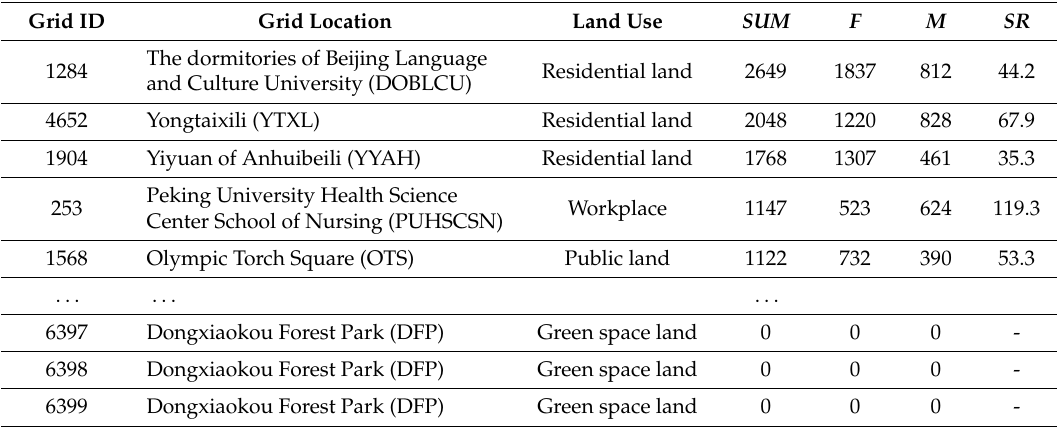
Table 2. The partial statistical results of the quantities of microblog users in June 2014. Grid